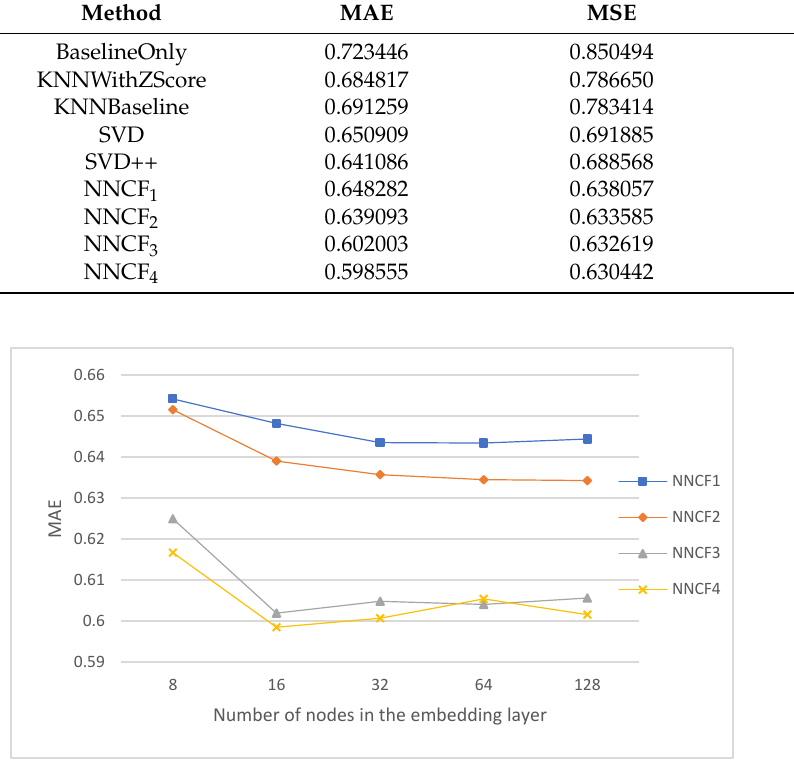
Figure 6. Effect of the number of nodes in the embedding layer of the NNCF predictors.